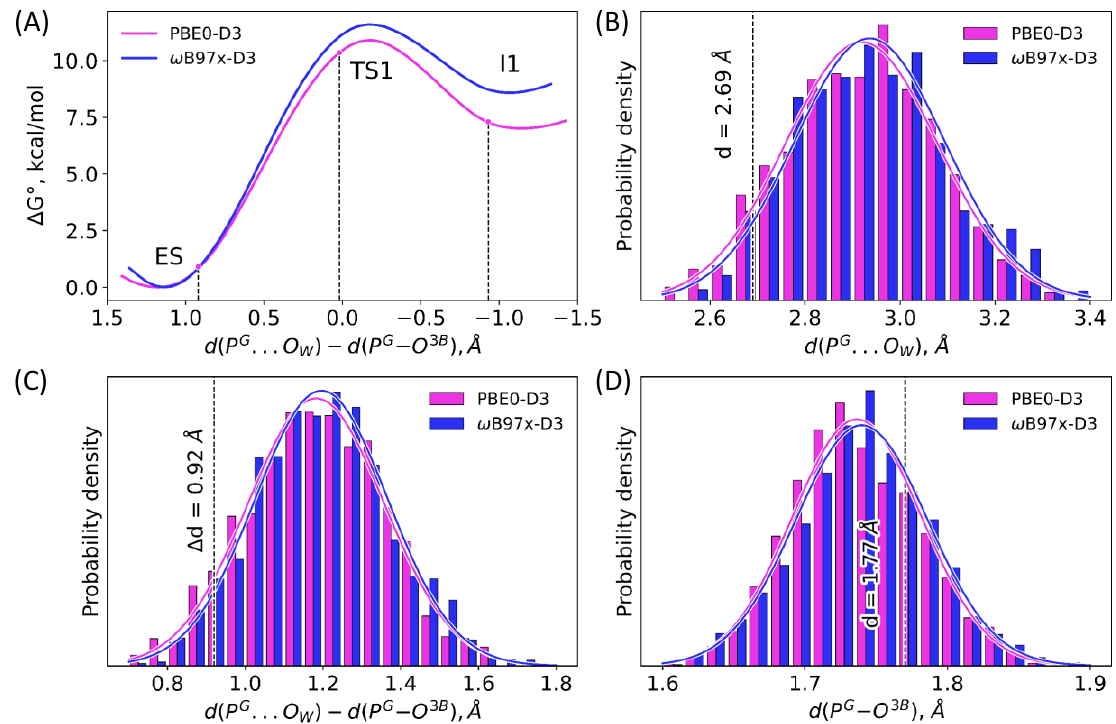
Figure 4. ( A ) Gibbs energy profiles of the first reaction step obtained in QM/MM MD simulations. ( B – D ) Distributions of the d(P G –O 3B ), d(P G . . . O W ) and d(P G . . . O W )–d(P G –O 3B ) distances in the unconstrained QM/MM MD simulations. Black dashed lines correspond to the reaction coordinate values ( A , C ) and individual interatomic distances ( B , D ) extracted from the stationary points on PES [26]. Magenta and blue curves correspond to the calculations obtained with the PBE0-D3 and ωB97x-D3 functionals, respectively.